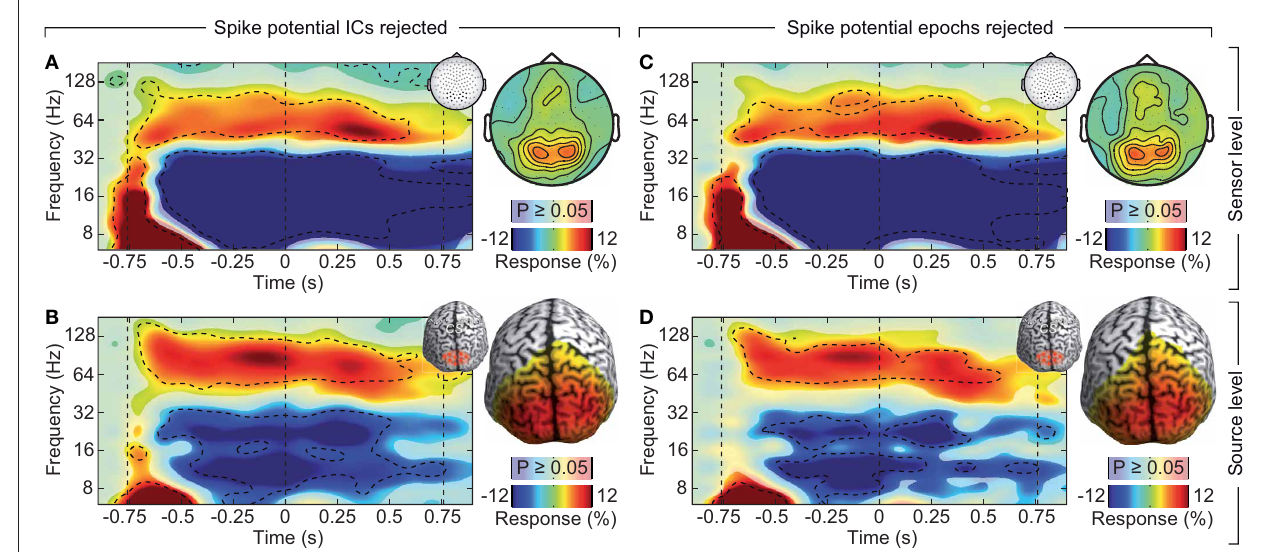
FIGURE 8 | Effect of rejecting cranial muscle artifacts and saccadic spike artifacts. Same sensor-level and source-level analysis of stimulus induced responses as displayed in Figures 2 , 4 . (A,C) Left: power response relative to prestimulus baseline resolved in time and frequency for occipito-parietal electrodes of interest (see insets for electrode positions). Statistically significant differences are indicated by saturated colors ( t -test, p < 0 . 05), and by contour lines ( t -test, p < 0 . 05,